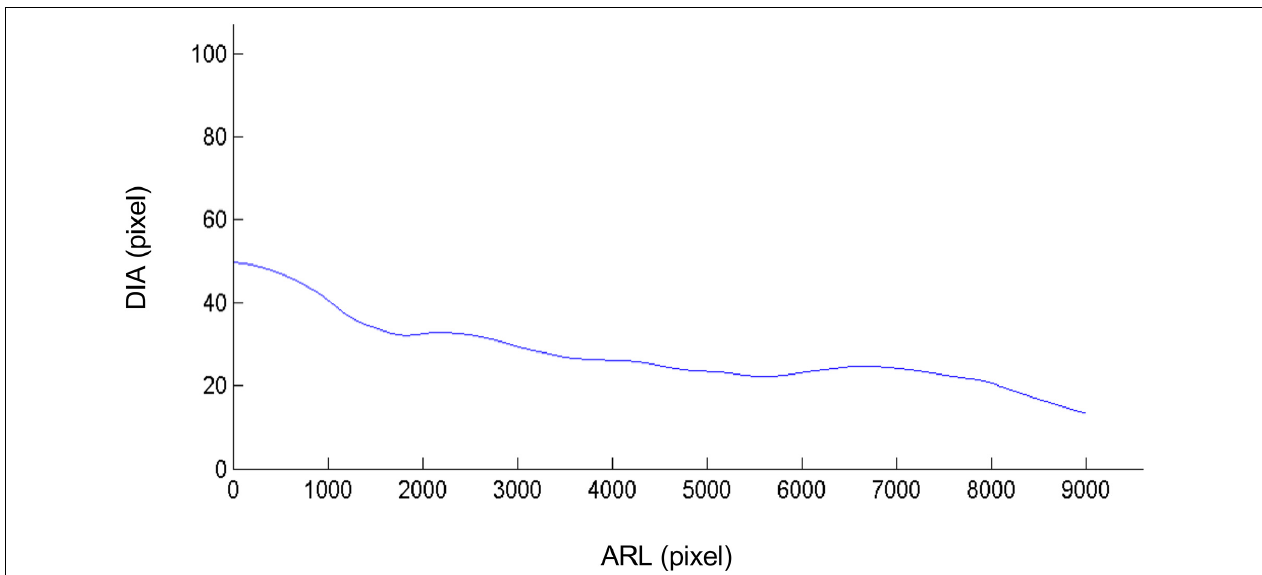
FIGURE 6 | Local diameter in pixels of the adventitious root along its length. From the adventitious root identified and reconstituted by the algorithm, the calculation of its local diameter becomes possible by measuring the number of pixels occupied by the root throughout its length, allowing therefore the measurements of more diverse parameters such as the diameter of the root apexes in different stress conditions. In this case the root diameter is indeed decreasing as the distance from the cutting gets further. DIA: Diameter and ARL: Adventitious Root Length. The values of the diameter are after converted in mm using image calibration procedure: in our case 1 pixel is equivalent to 1 mm.